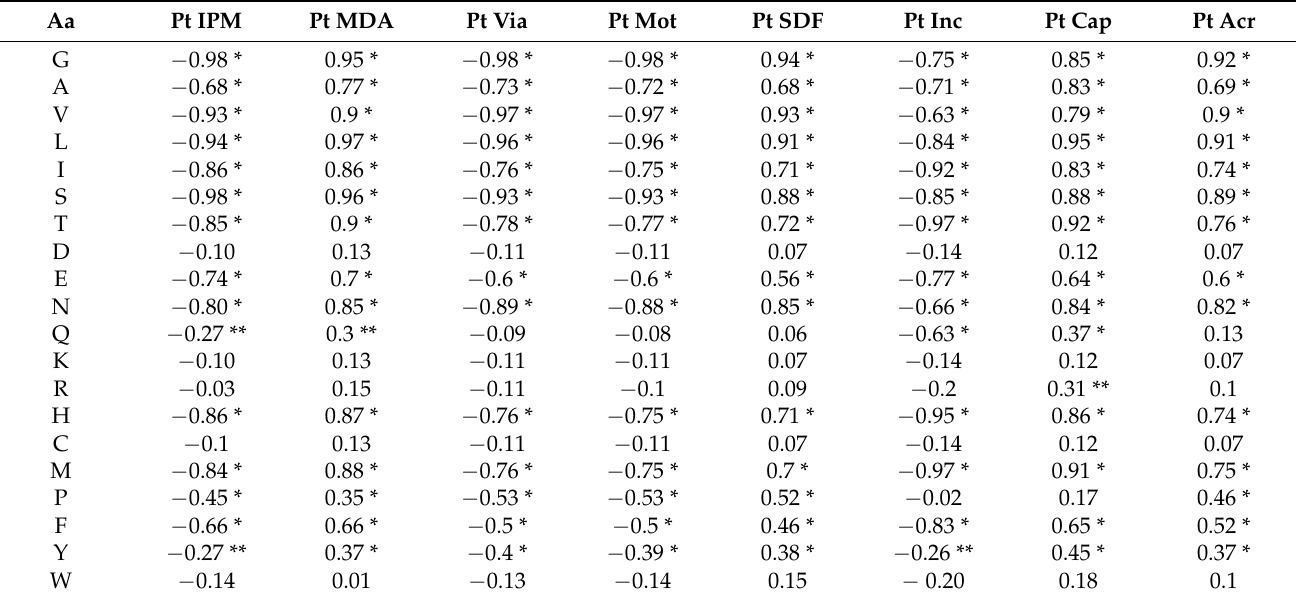
Table 6. Correlation coefficient of amino acid mutation and parameter of post-thawed Kacang buck